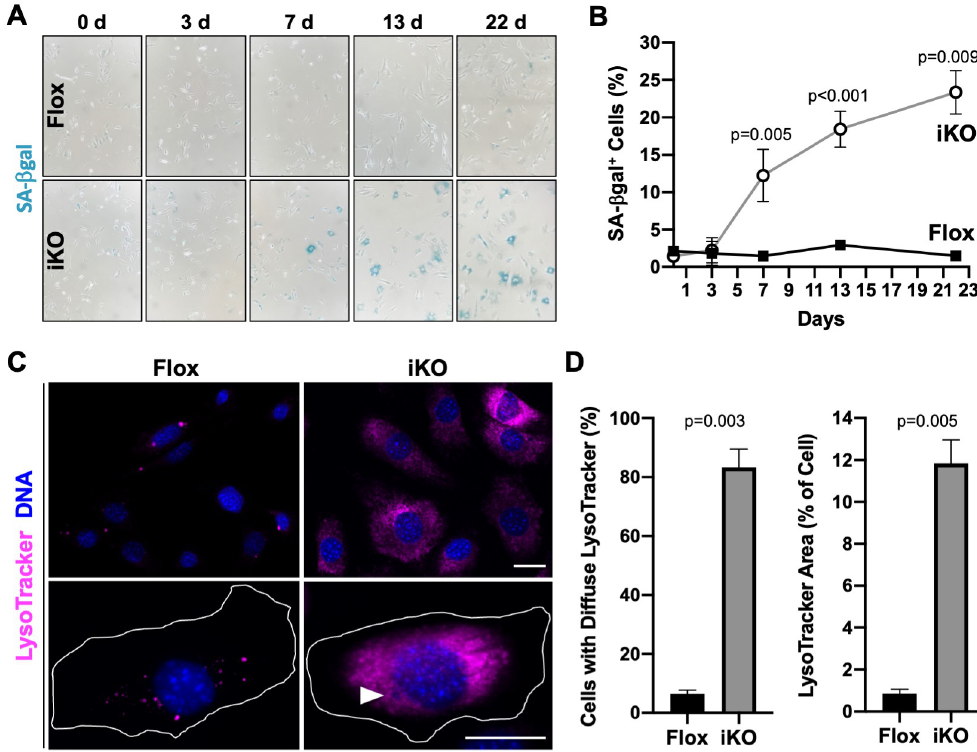
Fig 3. SA- β gal activity and lysosomal staining are increased in ArpC2 iKO cells. (A) Mouse fibroblasts were treated with DMSO (Flox) or 4-OHT (iKO) for 0-6d and senescence-associated beta-galactosidase (SA- β gal) staining was performed over a 22d period. (B) The % of SA- β gal-positive cells was quantified by calculating the number of intensely blue-colored cells divided by the total number of cells. Each point represents the mean % ± SD from a representative 0d timepoint, n = 2 experiments for the 3d and 22d timepoints, and n = 3 experiments for the 7d and 13d timepoints (727–2197 cells per point). (C) Flox and iKO cells at 9d were treated with LysoTracker (magenta), fixed, and stained with DAPI (DNA; blue). The magnifications illustrate punctate versus diffuse LysoTracker staining, and the arrowhead indicates the position of a micronucleus. Scale bars, 25 μ m. (D) The % of cells exhibiting diffuse LysoTracker staining was quantified by scoring the number of cells with broad instead of punctate cytoplasmic fluorescence and dividing by the total number of cells. The relative area within each cell occupied by LysoTracker was quantified using the threshold function in ImageJ. Each bar represents the mean % ± SD from n = 2 experiments (151–155 cells per